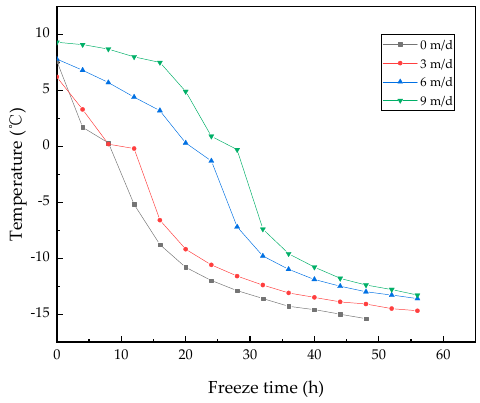
Figure 8. Temperature variation at C7 with different velocities.